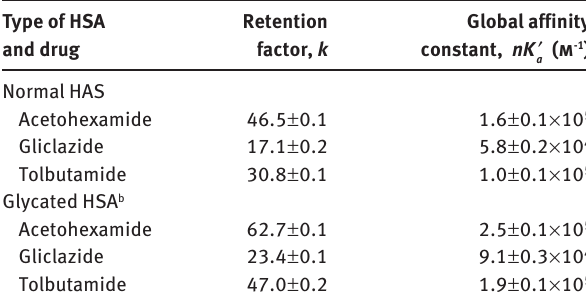
Table 3 Specific retention factors and global affinity constants for sulfonylurea drugs on columns containing normal HSA or in vitro glycated HSA.